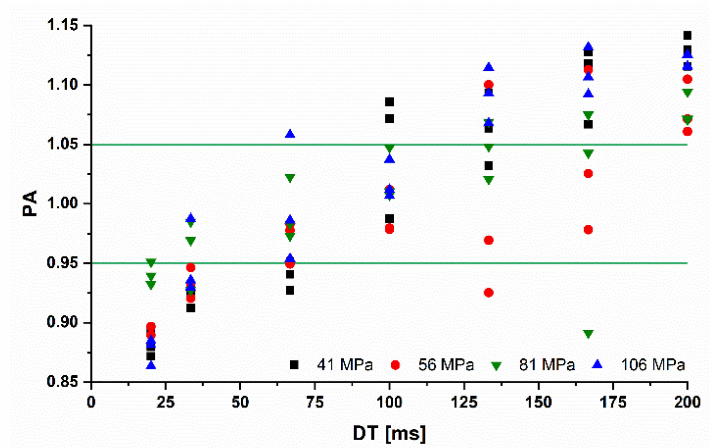
Figure 4. Prediction accuracy ( PA ) for MCC ribbons with changing dwell times from 20 to 200 ms; individual values; n = 3; green horizontal bars = PA of 1.00 ± 0.05.